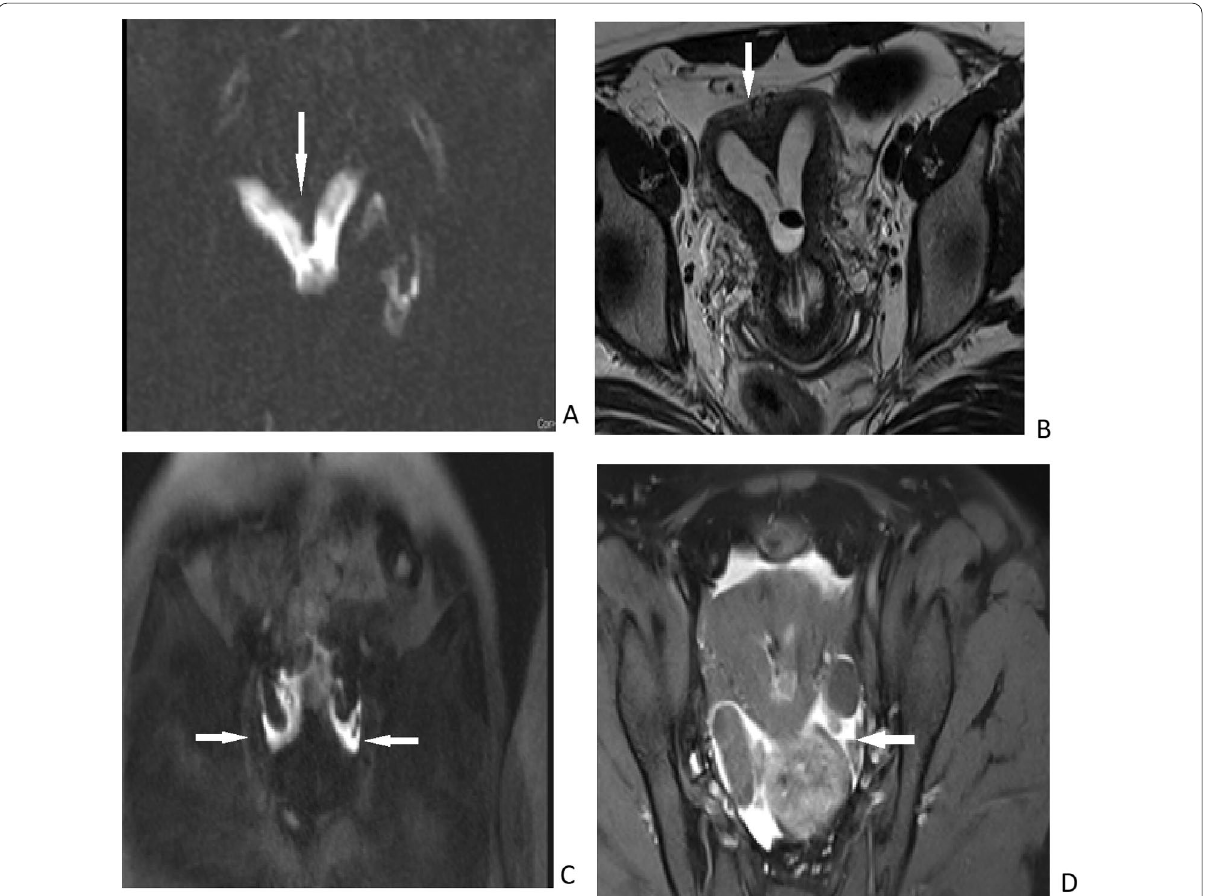
Fig. 6 In 31-year-old woman, subtracted dynamic 3D T1-weighted angiographic (TRICKS) MR HSG image shows indention of fundus (arrow) ( A ). Coronal T2-weighted image through uterus shows indentation of serosal contour of fundus, myometrium and endometrium into uterine canal, indicating septate uterus (arrow) ( B ). Image from subtracted dynamic 3D T1-weighted angiographic series (time-resolved imaging of contrast kinetics [TRICKS]) in 45-year-old woman shows bilateral spill of contrast material (arrows) ( C ). Postcontrast fat sat T1W axial image showing fluid in peritoneal cavity (arrow) ( D